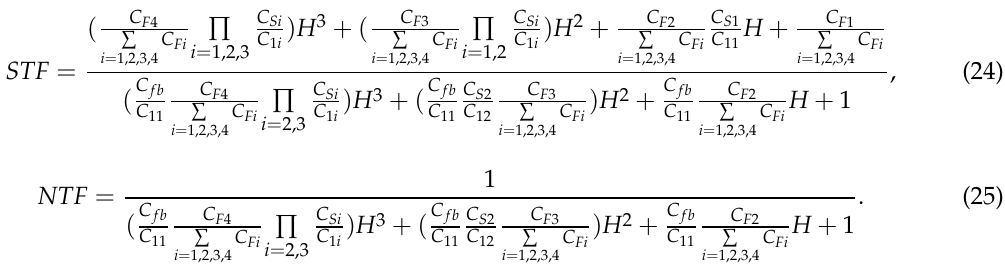
Figure 9. Circuit design of cascade-of-integrators, feedforward (CIFF) ΣΔ analog modulator. According to Figure 9, the signal transfer function (STF) and noise transfer function (NTF) of the modulator can be obtained as